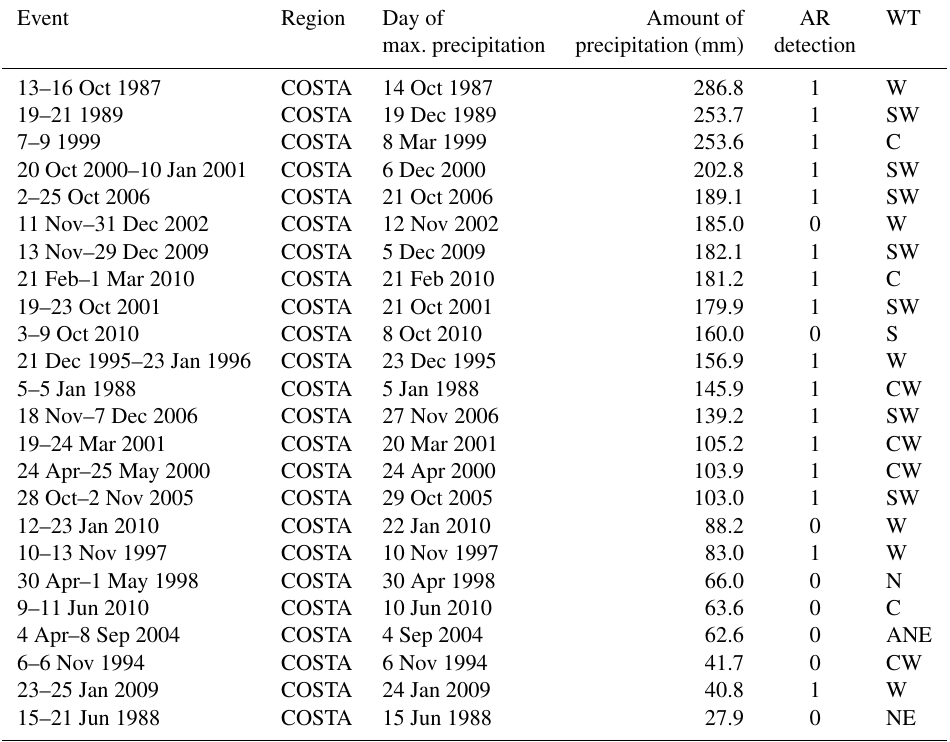
Table A2. FEs included in the analysis, listed in descending order of precipitation amount for the COSTA region. Event